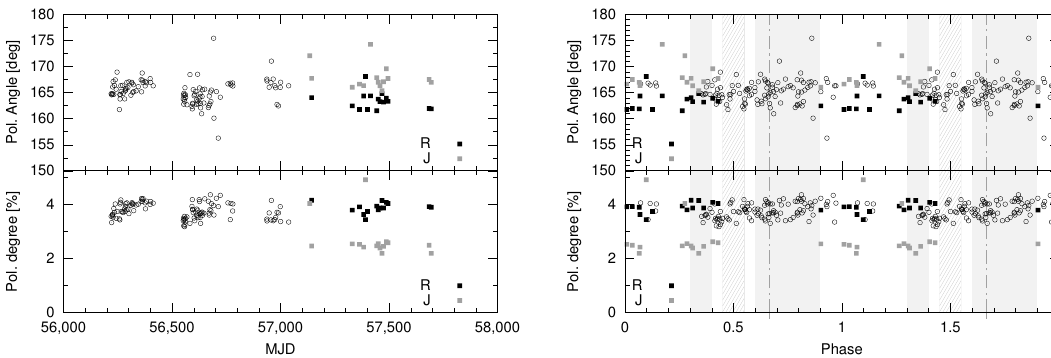
Figure 11. The same as Figure 4, but for HESS J0632 + 057 with Kanata/HOWPol (until MJD 57,042, R -band) and Kanata/HONIR (from MJD 57,330, R -band, and from MJD 57,139, J -band). See Figure 5 for the shaded and striped area.